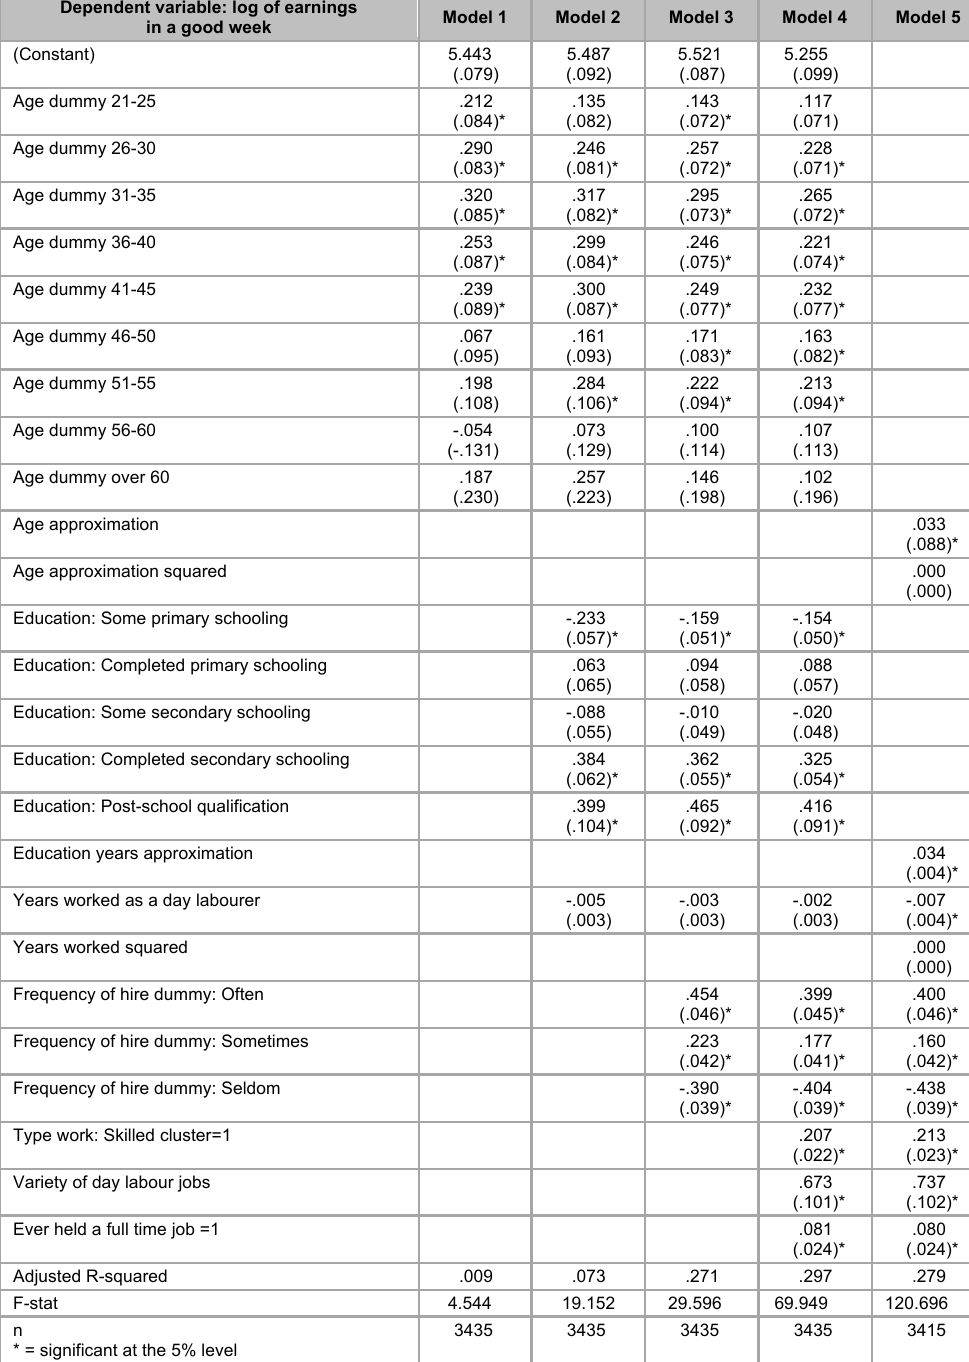
Regression results: Explaining earnings in a good